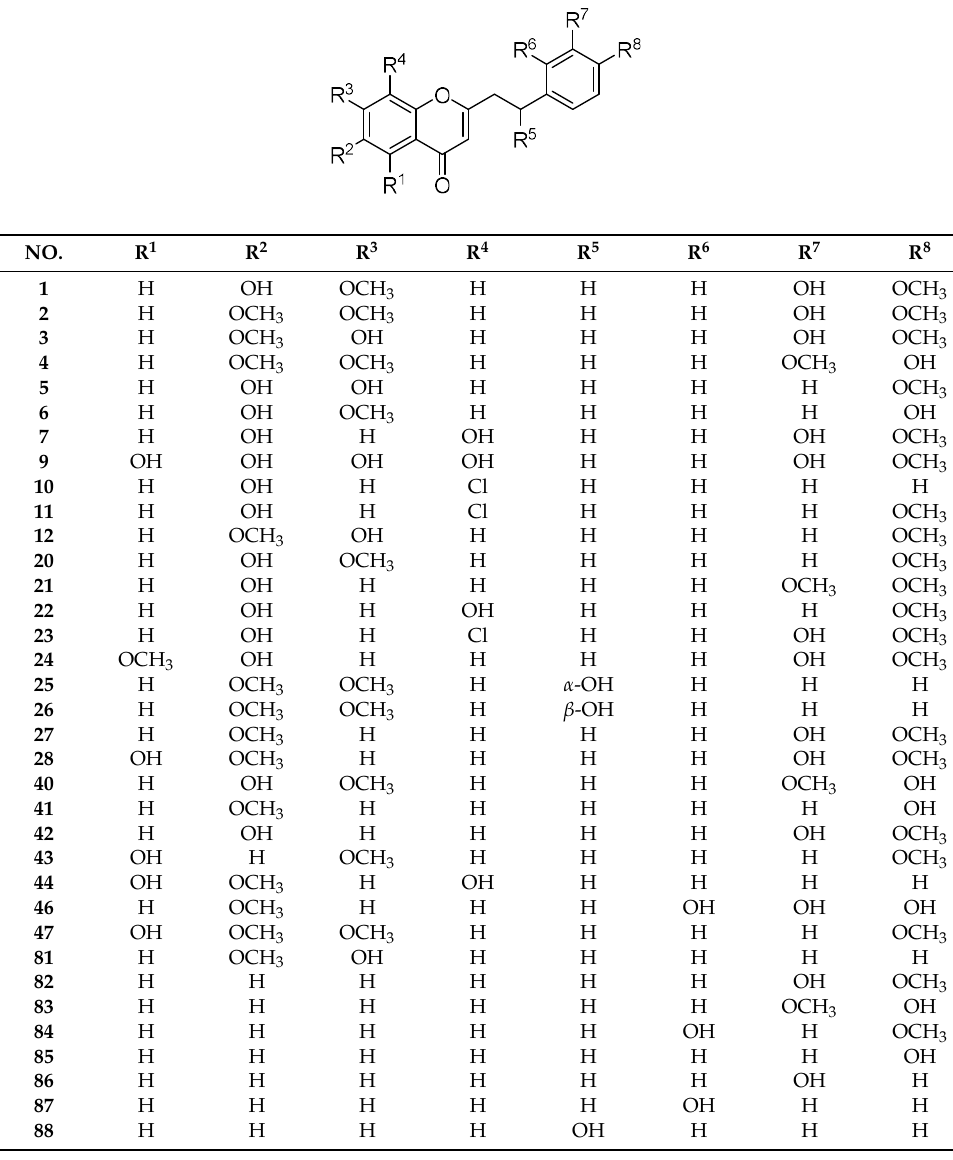
Figure 1. Structures of chromones identified in agarwood. Molecules 2018 , 23 , x